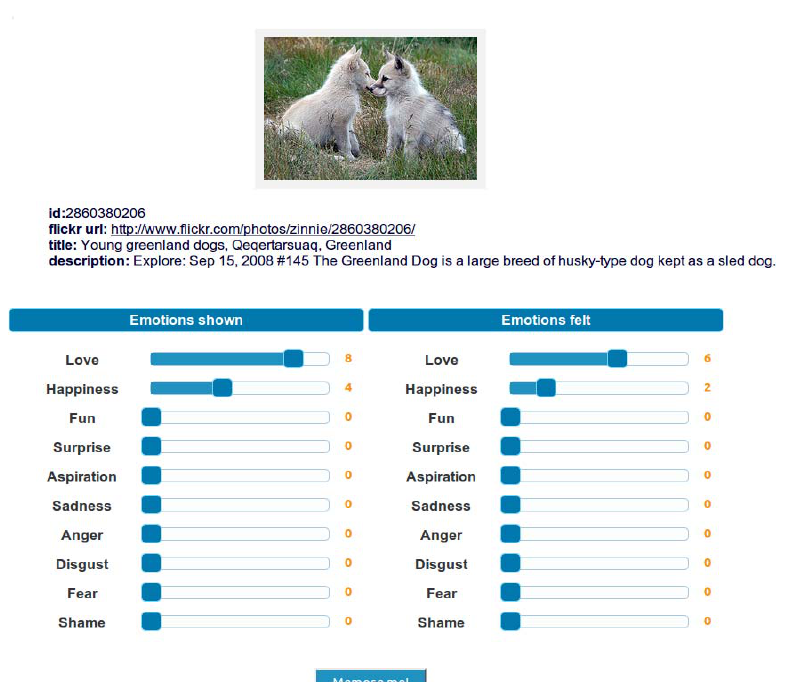
Figure 2. Tagging an image with emotional